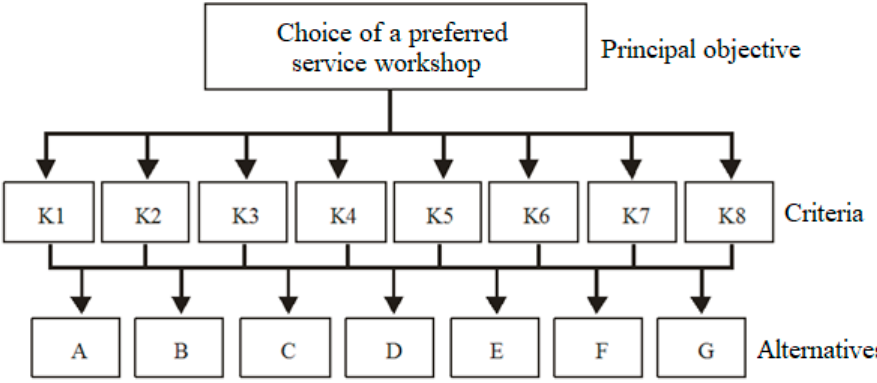
Figure 5. Hierarchical structure of the process of choosing a service workshop.